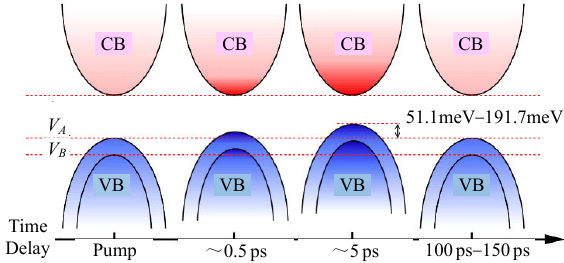
Fig. 5 Schematic illustration of MoS 2 band structure as a function of decay time. VA presents the initial energy of A exciton, while VB presents the initial energy of B exciton. The reductive energy of A exciton during the renormalization within 5 ps increase from 51.1 meV to 191.7 meV with a decrease in